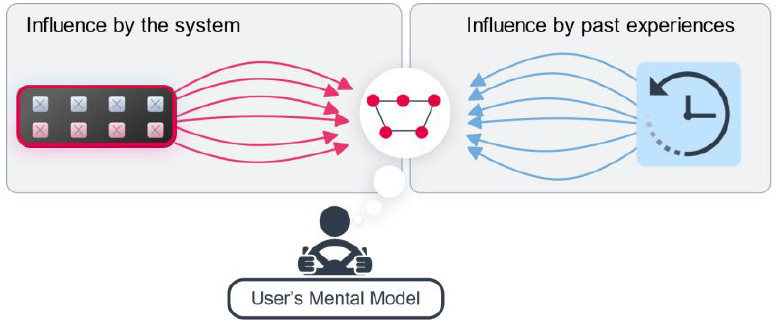
Figure 1. Main influencing factors on the formation of the user’s mental model.